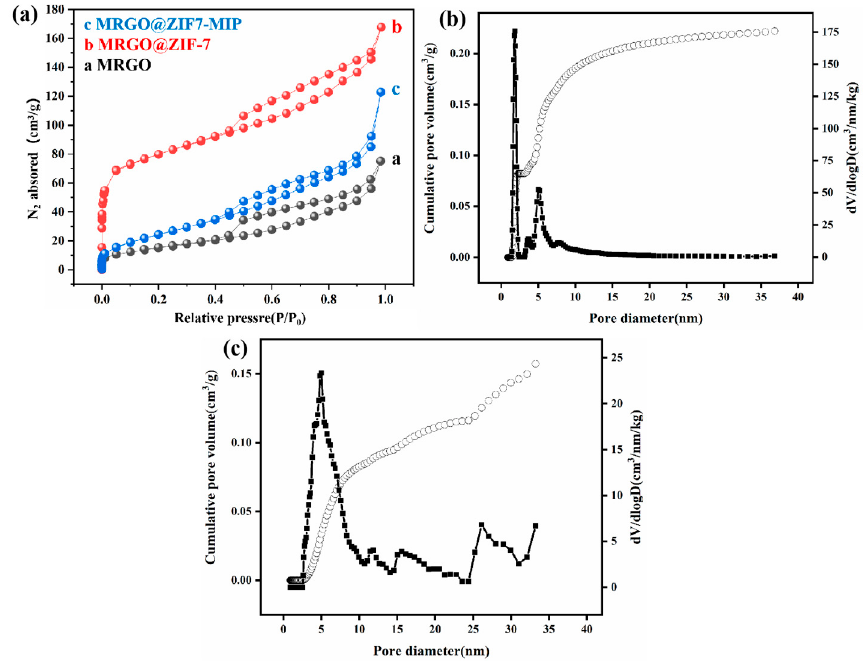
Figure 3. ( a ) The nitrogen adsorption–desorption isotherms of MRGO@ZIF7-MIP, MRGO@ZIF-7 and MRGO and ( b , c ) pore size distribution of MRGO@ZIF-7 and MRGO@ZIF7-MIP.